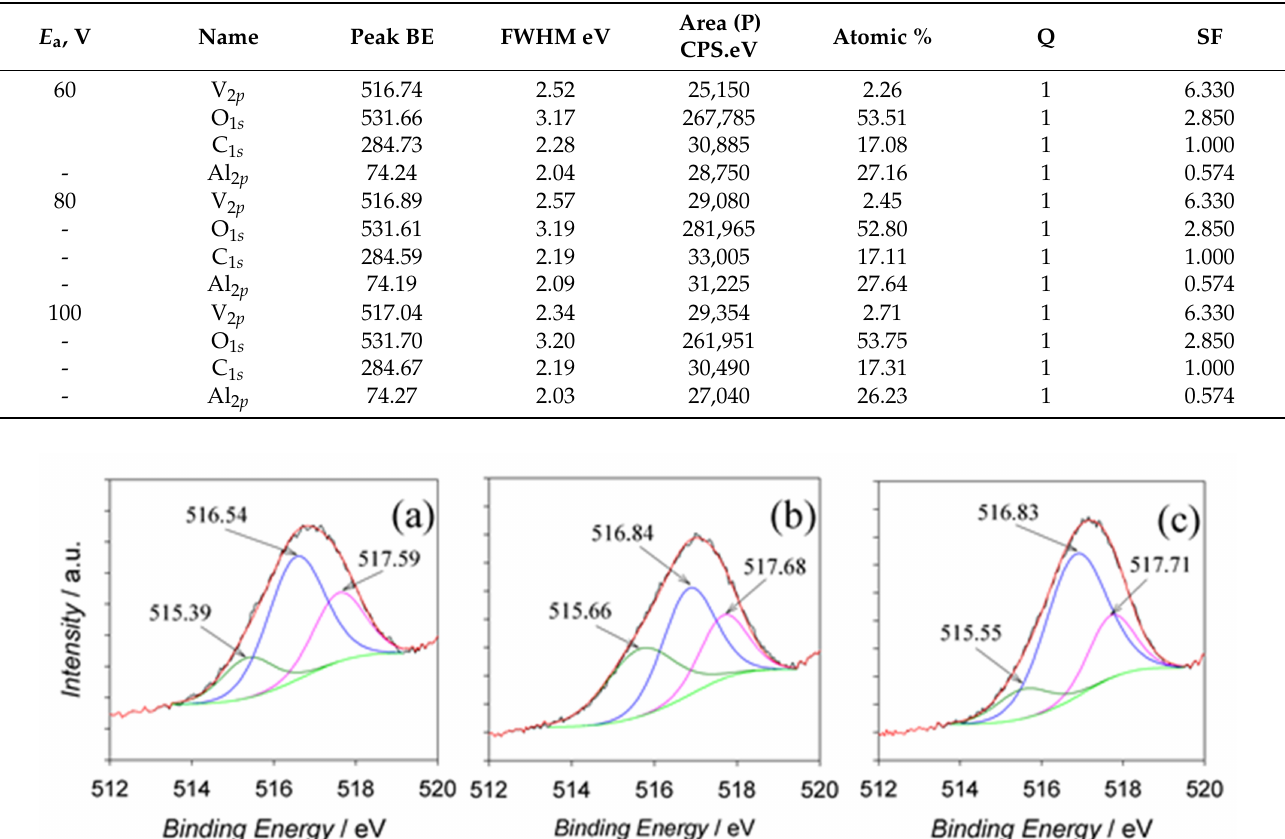
Figure 4. Deconvoluted V2 p3/2 XPS spectra of vanadium species entrapped inside the films fabricated by Al anodization in a solution containing 0.2 mol · L − 1 NaVO3 and 0.8 mol · L − 1 HCOOH (pH 2.5) at E a values of ( a ) 60, ( b ) 80, and ( c ) 100 V for 60 min. Quantification of their peak areas (see Table 1) revealed the dominant presence of